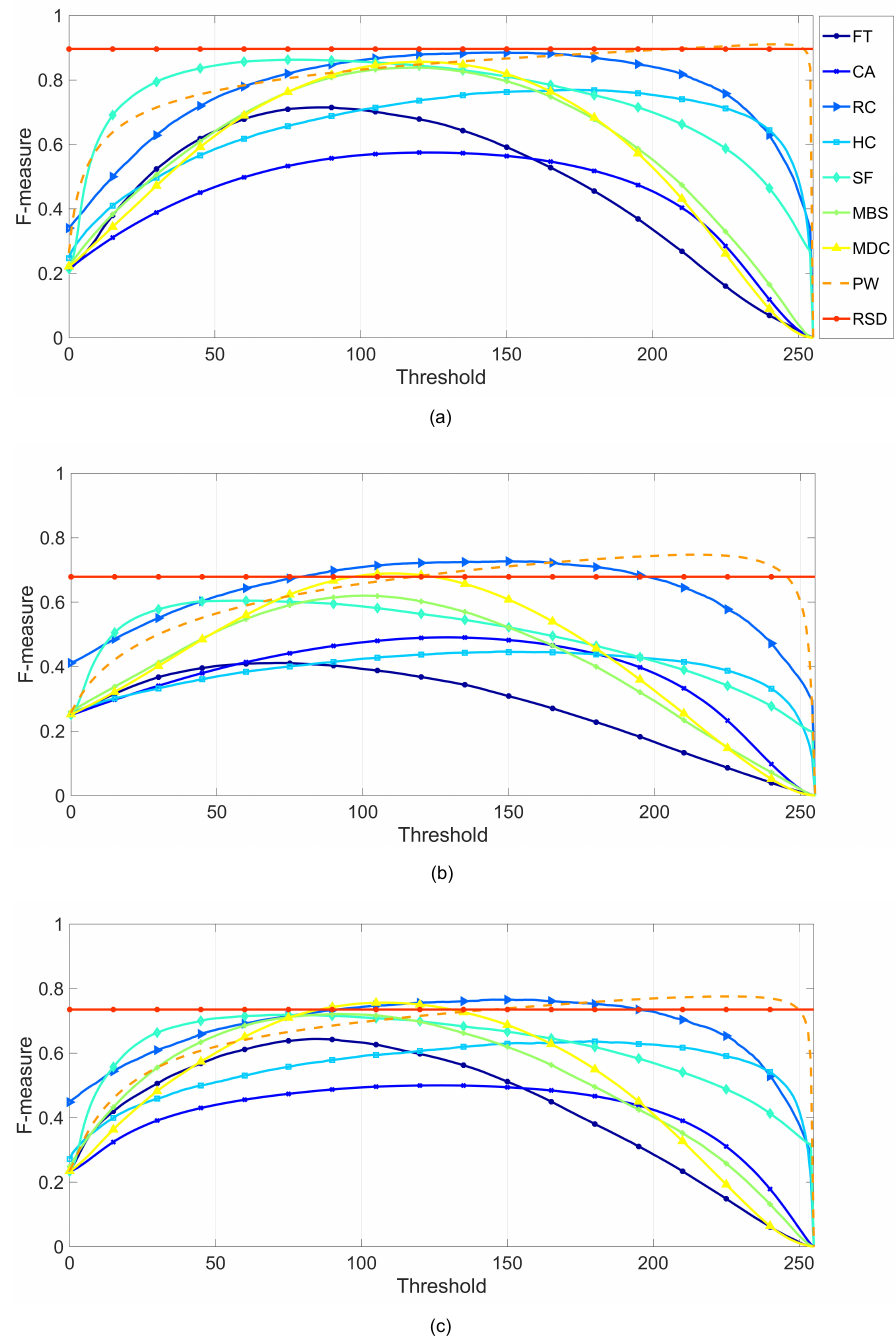
Figure 7. Comparison of the F-measure curve obtained with different thresholds for eight state-of- the-art algorithms and our approach RSD on three representative benchmark datasets: ( a ) MSRA1K dataset; ( b ) ECSSD dataset; and ( c ) iCoseg